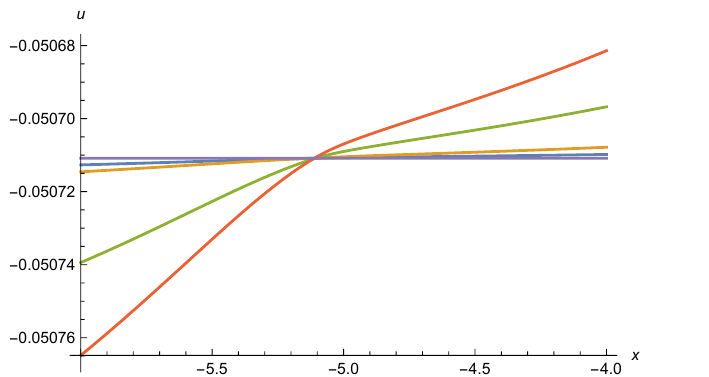
Figure 21. Effective potential u as function of x = ln ˜ ρ for ξ ∞ = 2 · 10 − 5 (blue), 10 − 4 (orange), 10 − 3 (green), and 0.003 (red), from bottom to top on the right side. The constant scaling solution, given by the horizontal line, is approached for ξ ∞ → 0. All curves meet in a common point at x ≈ − 5.05.